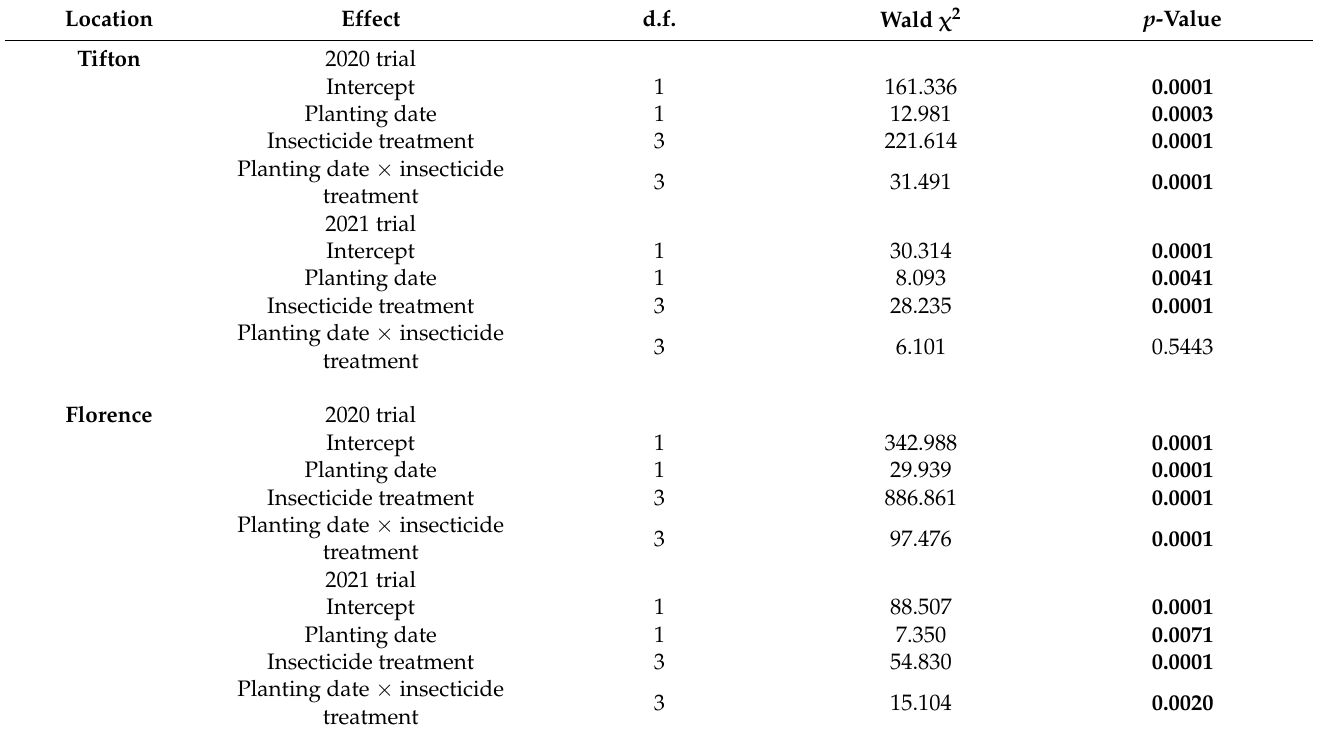
Table 1. Generalized linear model (GLM) results for effects of planting date, insecticide applications and their interaction on cumulative insect days (CID) in the 2020 and 2021 study at Tifton, Georgia and Florence, South